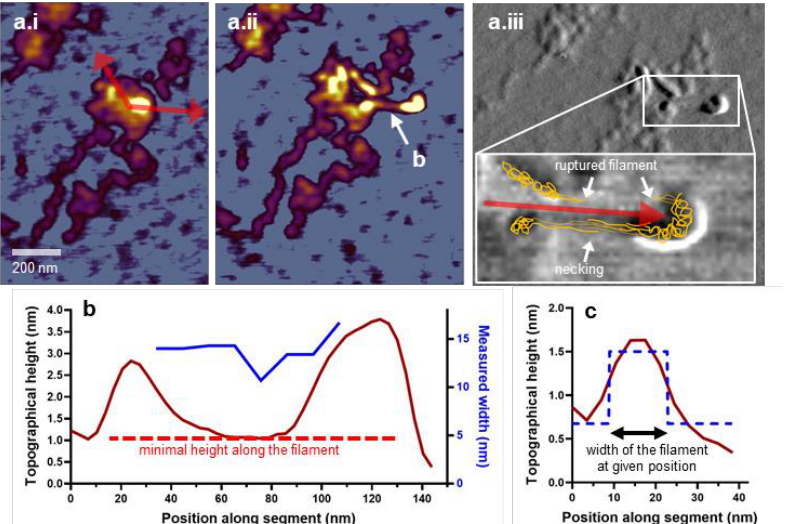
Figure 6. Ductility and necking in the nanosurgically manipulated M-complex. ( a.i ) Height-contrast AFM image of a titin oligomer before manipulation. Arrows indicate the site, direction, and distance of the manipulation. ( a.ii ) AFM image recorded after the nanosurgical manipulation. White arrow points at the titin strand analyzed for topographical height and width. ( a.iii ) Phase-contrast AFM image of the manipulated M-complex. The boxed area is enlarged in the inset and supplemented with a schematic drawing of the likely molecular arrangement in the pulled titin loop. The red arrow indicates the AFM tip motion during nanosurgical manipulation. Above the arrow, the titin strand has ruptured. By contrast, below the arrow, the titin strand has gone through necking, which entails the thinning of the structure in the middle. ( b ) Topographical analysis of the necked titin strand. Red and blue curves are the topographical height and width of the titin strand as a function of axial position along its length, respectively. ( c ) Method of calculating the width of the necked titin strand, by fitting a square function to its cross-sectional topographical